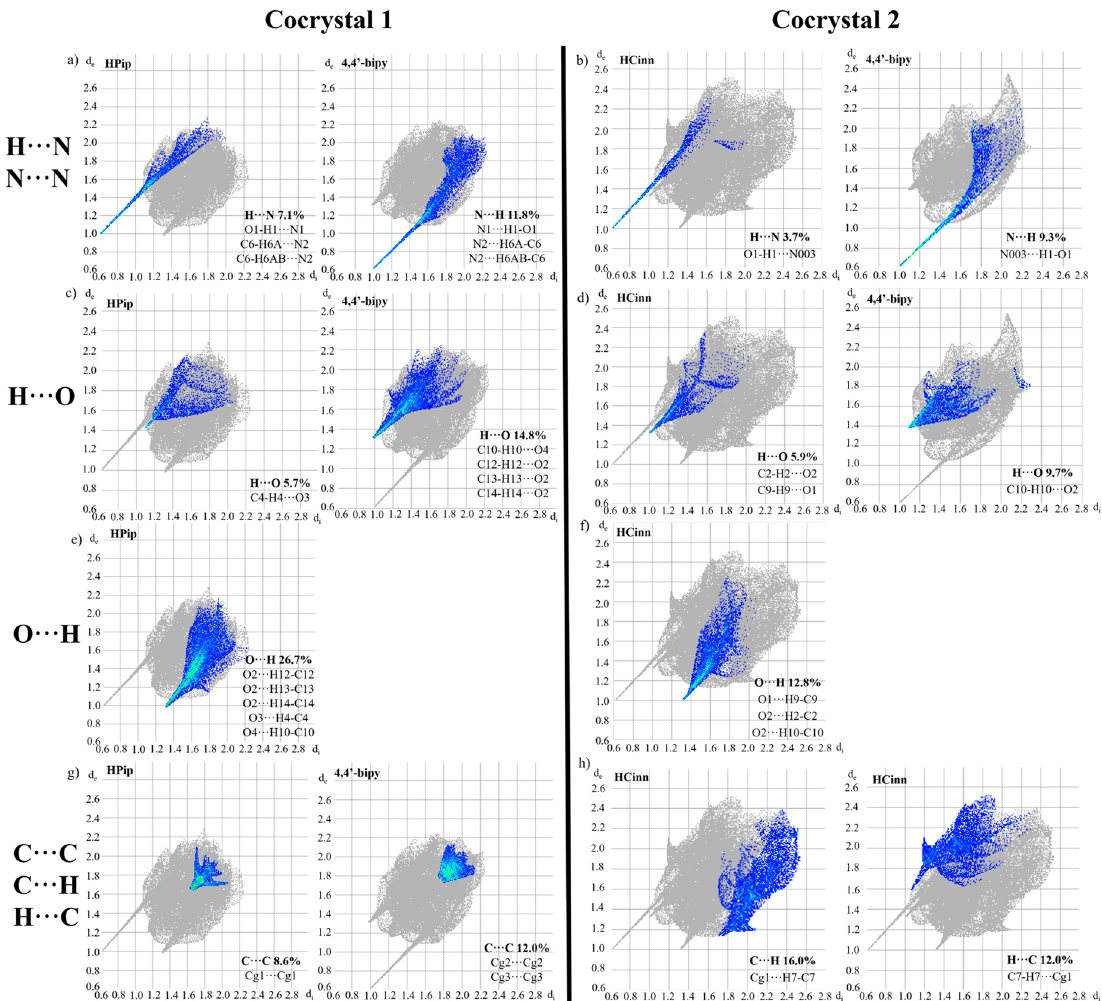
Figure 3. 2D fingerprint plots of H···N/N···H contacts in ( a ) 1 and ( b ) 2 . H···O contacts in ( c ) 1 and ( d ) 2 . O···H contacts in ( e ) 1 and ( f ) 2 . ( g ). C···C contacts in 1 and ( h ) C···H/H···C contacts in 2 .